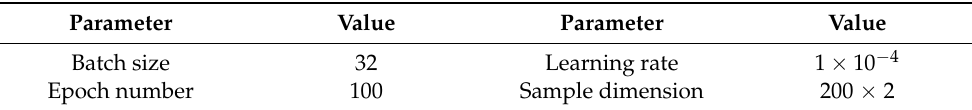
Table 3. Parameter